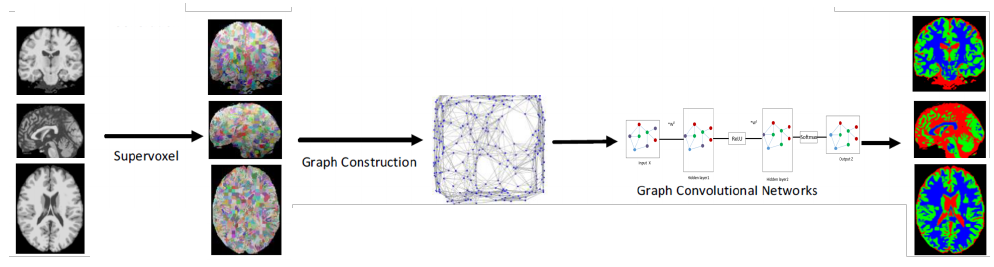
Figure 13. Supervoxels are generated from the brain MRI volume. A graph is constructed from these supervoxels with KNNs. A GCN is employed to classify supervoxels into different types of tissue. Image adapted from